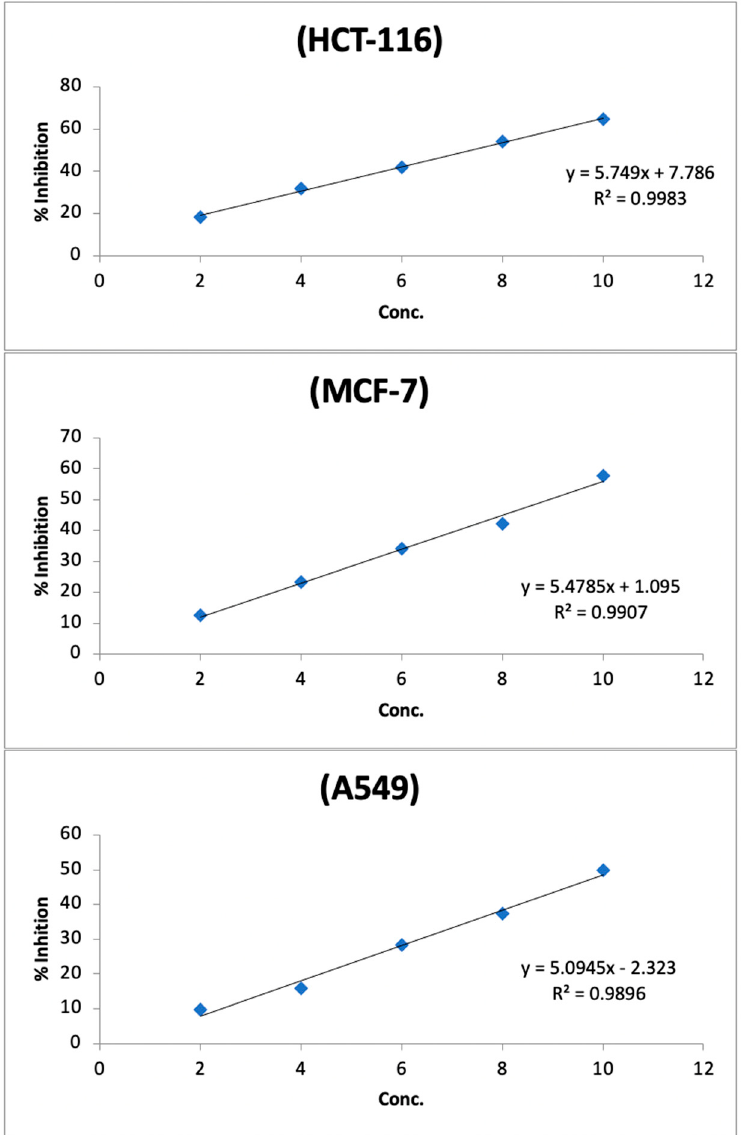
Figure 2. Anticancer activity of tested manuka honey towards three cancer cell lines, including colon cancer cells (HCT-116), breast cancer cells (MCF-7), and lung carcinoma epithelial cells (A549).